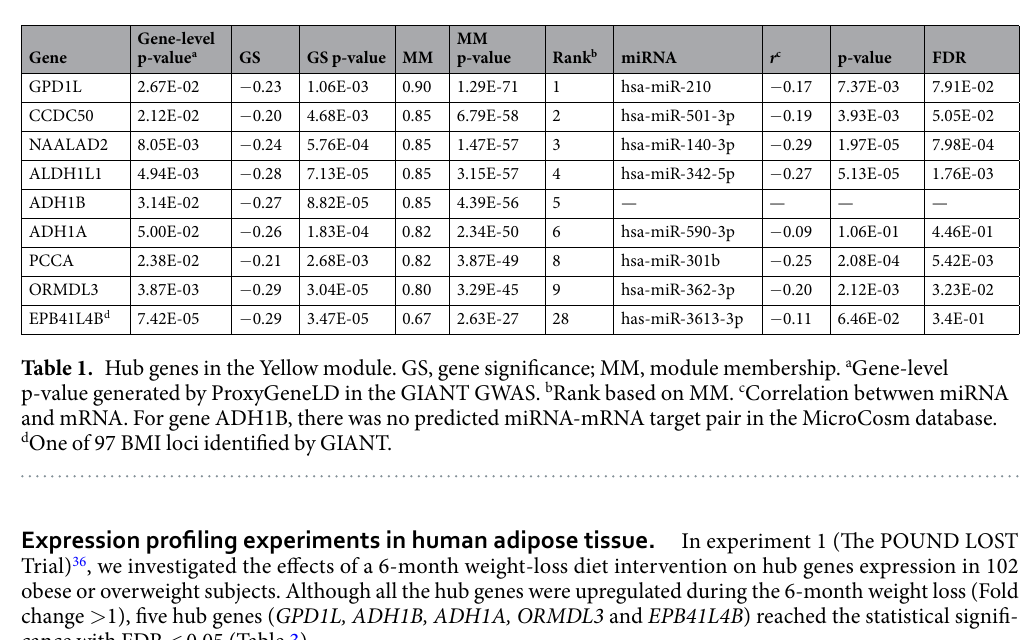
Gene-level p-value a GS